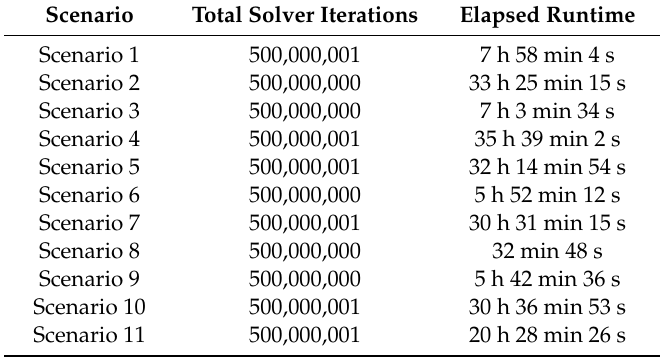
Table 3. Total solver iterations and elapsed runtime seconds for linear and nonlinear